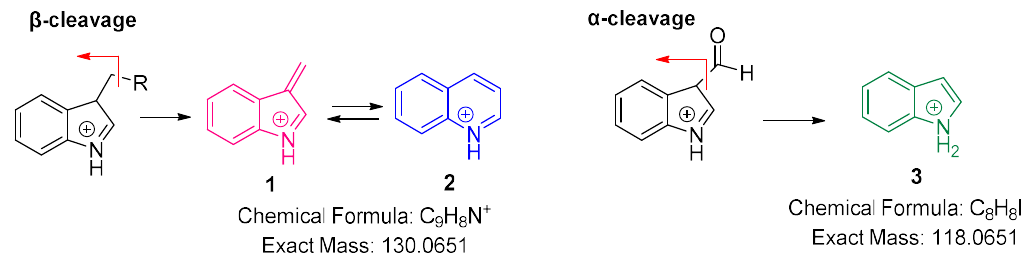
Figure 2. Fragments of 3-substituted indole compounds in the positive ion mode.